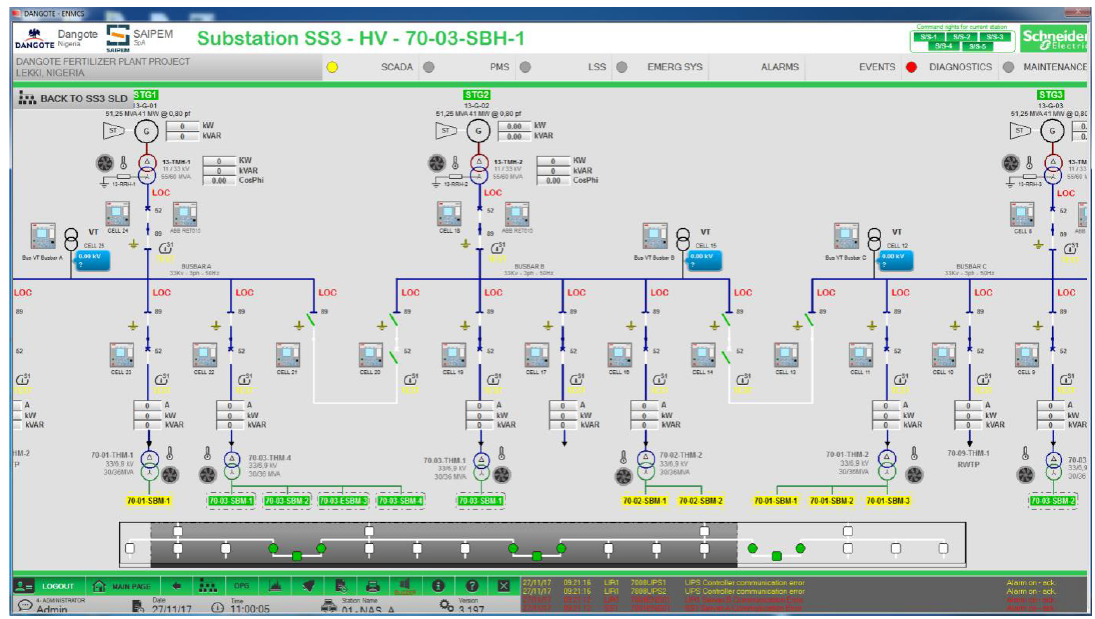
Figure 9. A screenshot sample of the man-machine interface (MMI) of the